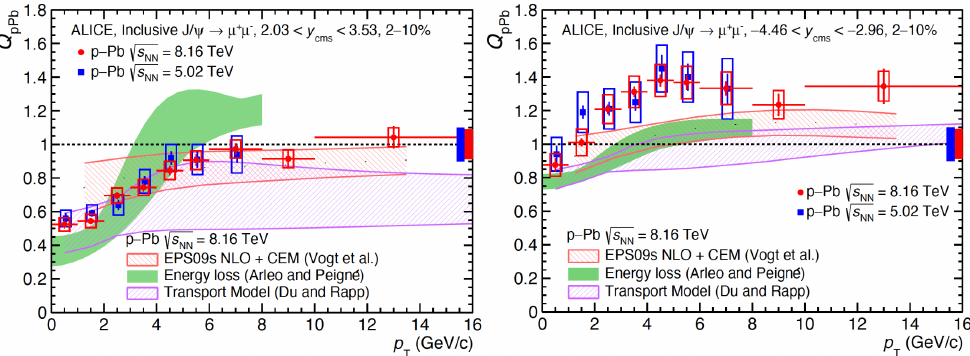
Figure 12. The J / ψ nuclear modification in p + Pb collisions as a function of p T for the 2–10% centrality class at forward ( left ) and backward ( right ) rapidity [68]. The red (blue) data points correspond to √ s NN = 8.16 (5.02) TeV collision energy. The data are compared with different theoretical models described in the text. Reprinted with permission from Springer Nature.